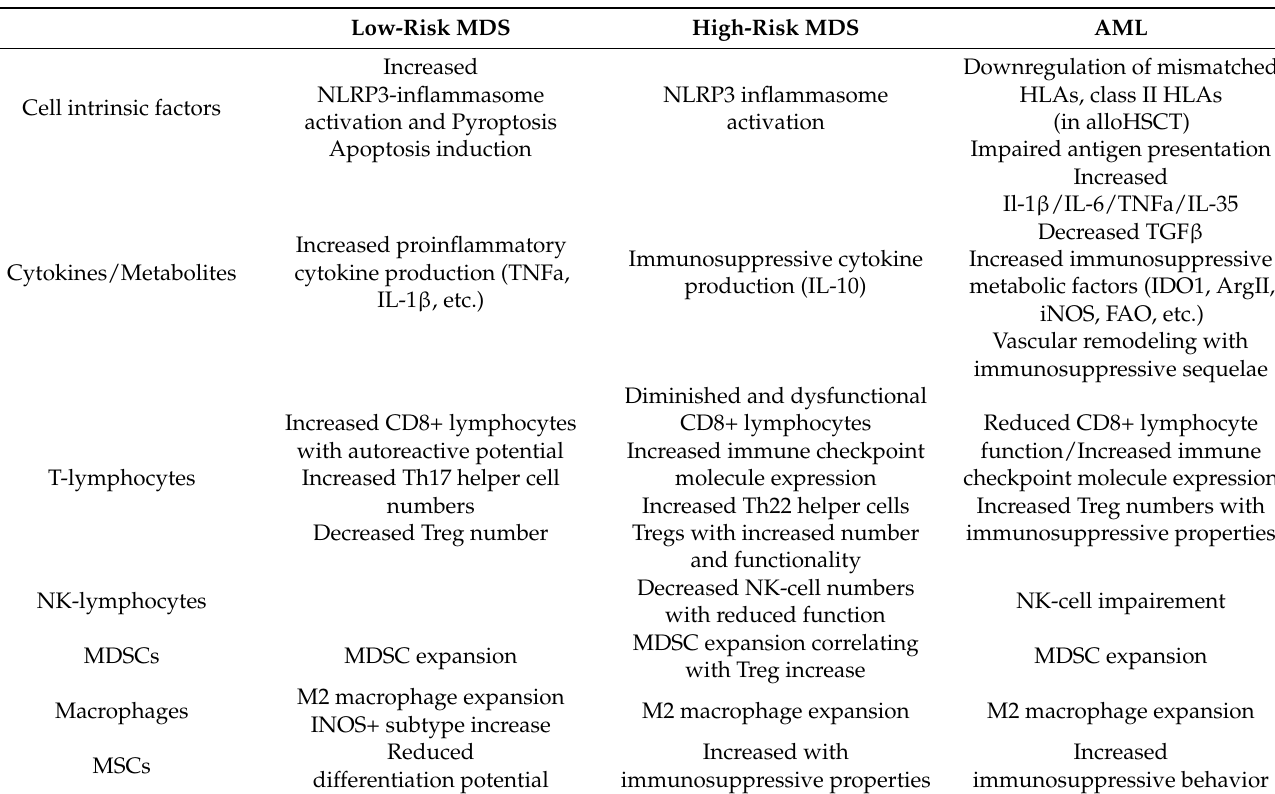
Table 1. Summarizing evidence regarding immunology in low-risk/high-risk MDS/AML. MDSC: myeloid-derived suppressor cells, MSCs: mesenchymal stem